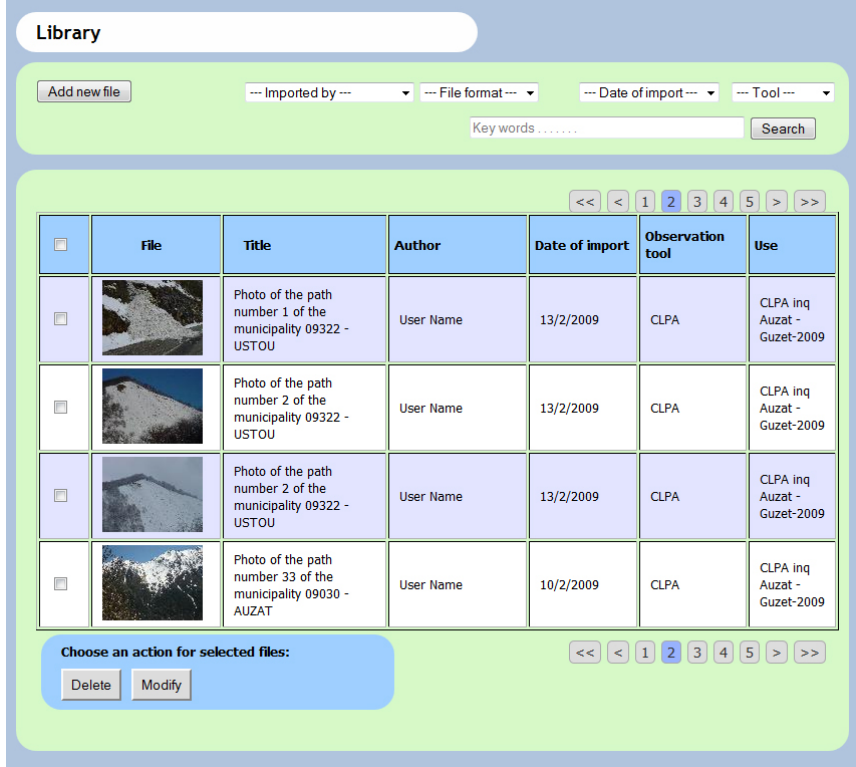
Figure 10. Digital library shared by the CLPA and EPA data